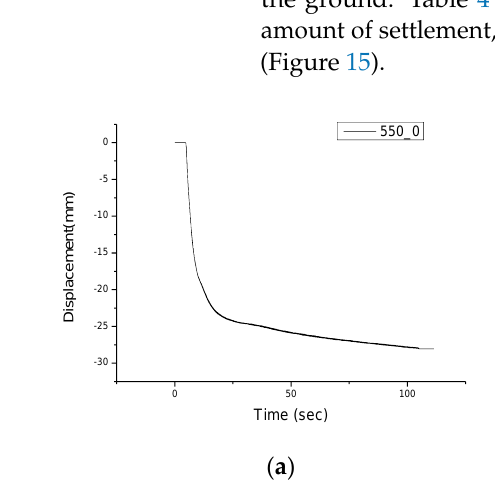
Figure 15. Grouting mixing ratio of 0.55 and separation distance of 0 cm: ( a ) Settlement ( b ) Pore Water Pressure Ratio. Table 4. Maximum settlement of grouting mixing ratio.